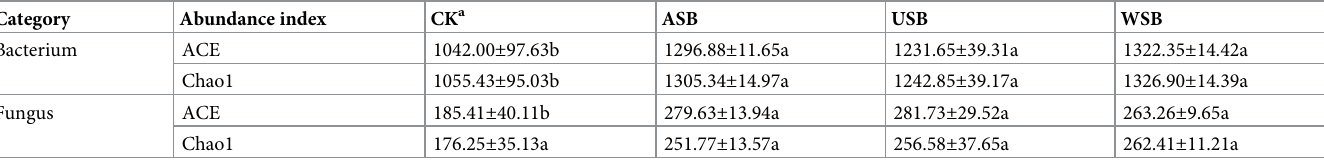
Table 3. Tea garden soil microbial richness in consecutive soybean planting and covering